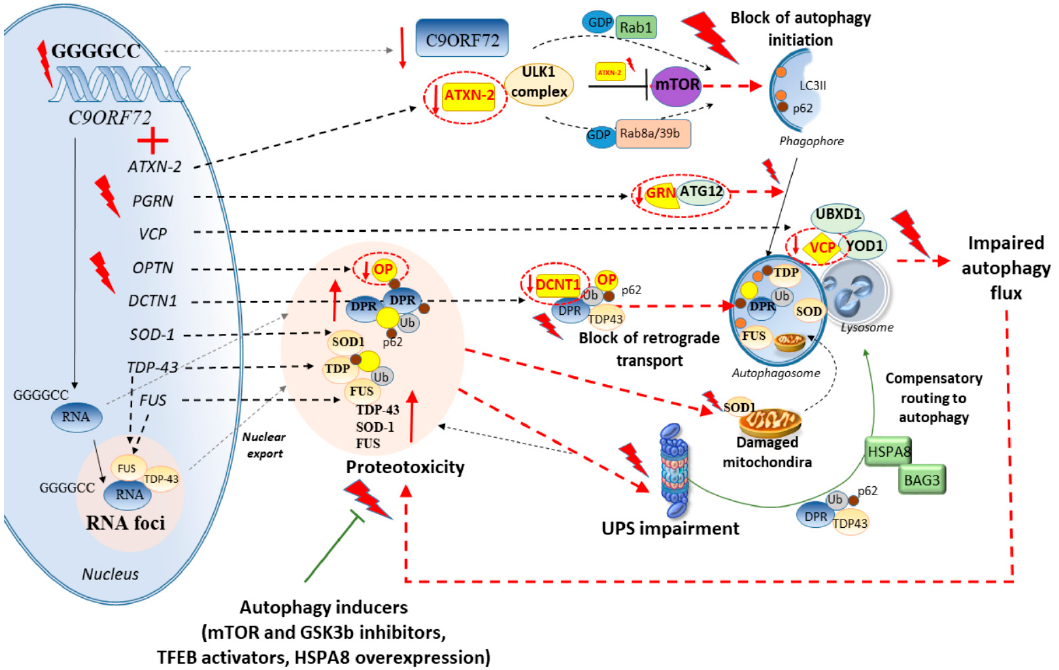
Figure 2. Mutated genes synergizing with C9ORF72 repeat expansions to produce proteotoxicity through autophagy and UPS impairment. Ataxin-2 ( ATNX-2 ) mutations may synergize with C9ORF72 repeat expansions to hamper autophagy initiation through occlusion of ATNX-2 -mediated mTOR inhibition. Progranulin ( PGRN ) mutations may hamper autophagosome formation by occluding the recruitment of ATG12. Valosin-containing protein ( VCP ) mutations may contribute to hampering autophagy flux by occluding the interaction with proteins (UBXD1 and YOD1) which mediate the fusion with lysosomes. Optineurin ( OPTN ) mutations occlude the targeting of ubiquitinated substrates or aggresomes to the UPS and autophagy pathways. Dinactin ( DCNT1 ) mutations occlude the retrograde transport of ubiquitinated substrates or aggresomes to the autophagy pathway. Superoxide dismutase 1 ( SOD1 ), TDP-43 , and FUS mutations contribute to increase the amount of intracellular autophagy. TDP-43 and FUS may also be sequestered within C9ORF72-induced RNA foci to be